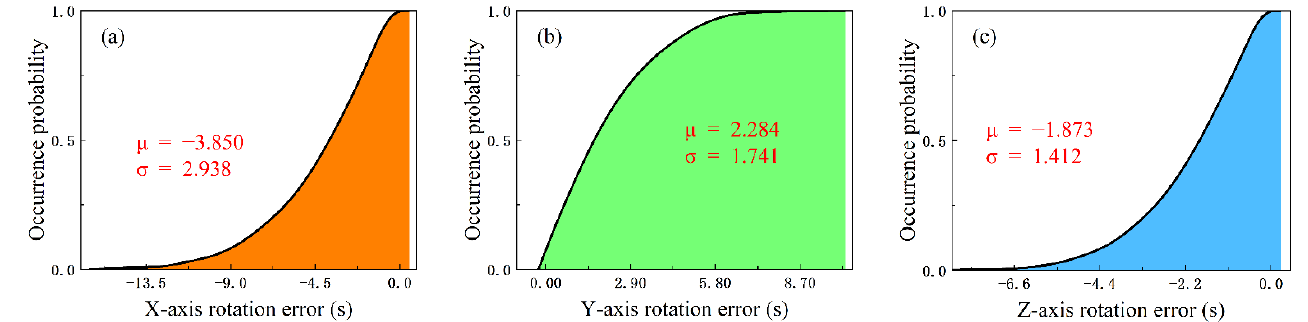
Figure 7. Simulation of angular errors in the establishment of a multi-source data datum alignment coordinate system. ( a ) probability distribution curve of the angular error in the X -axis. ( b ) probability distribution curve of the angular error in the Y -axis. ( c ) probability distribution curve of the angular error in the Z -axis.